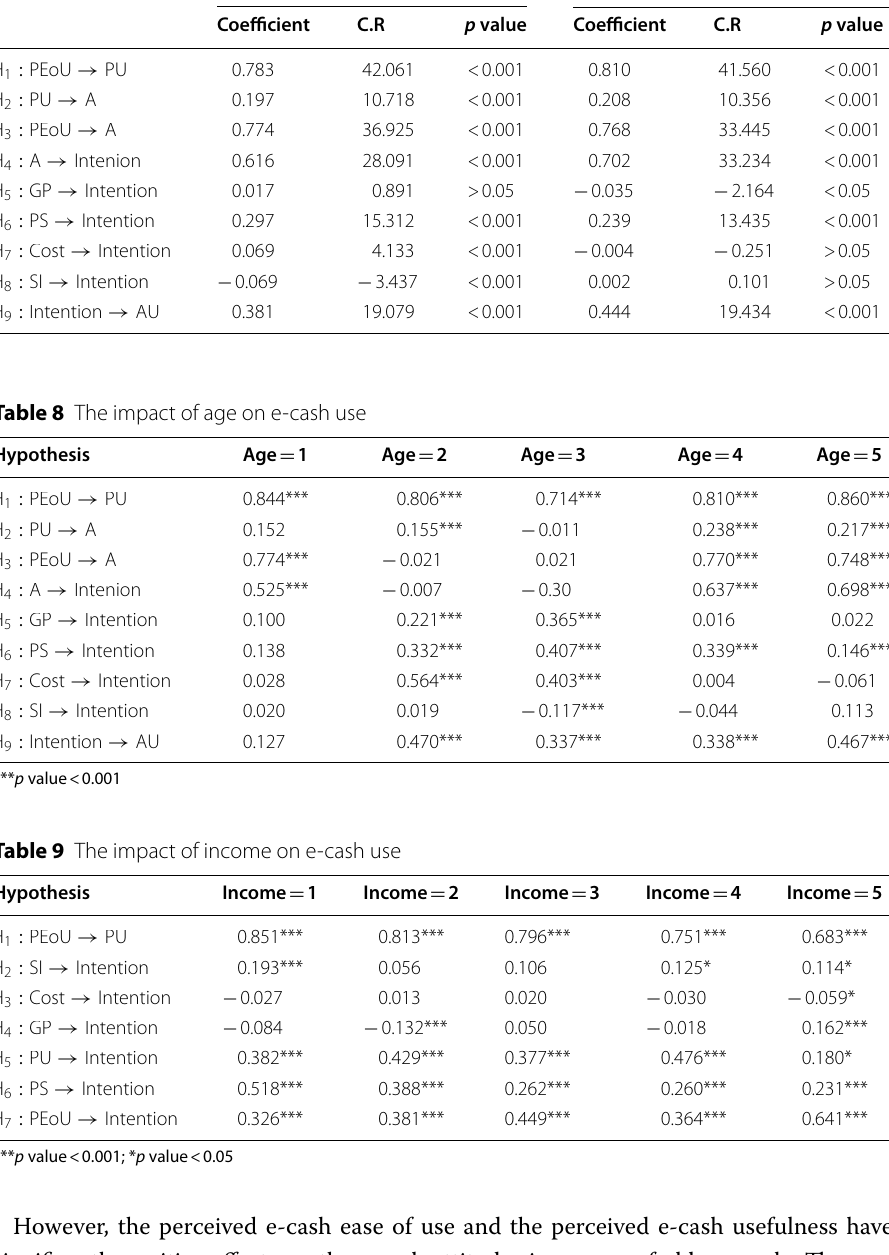
Table 7 The impact of gender on e-cash us Hypothesis Male